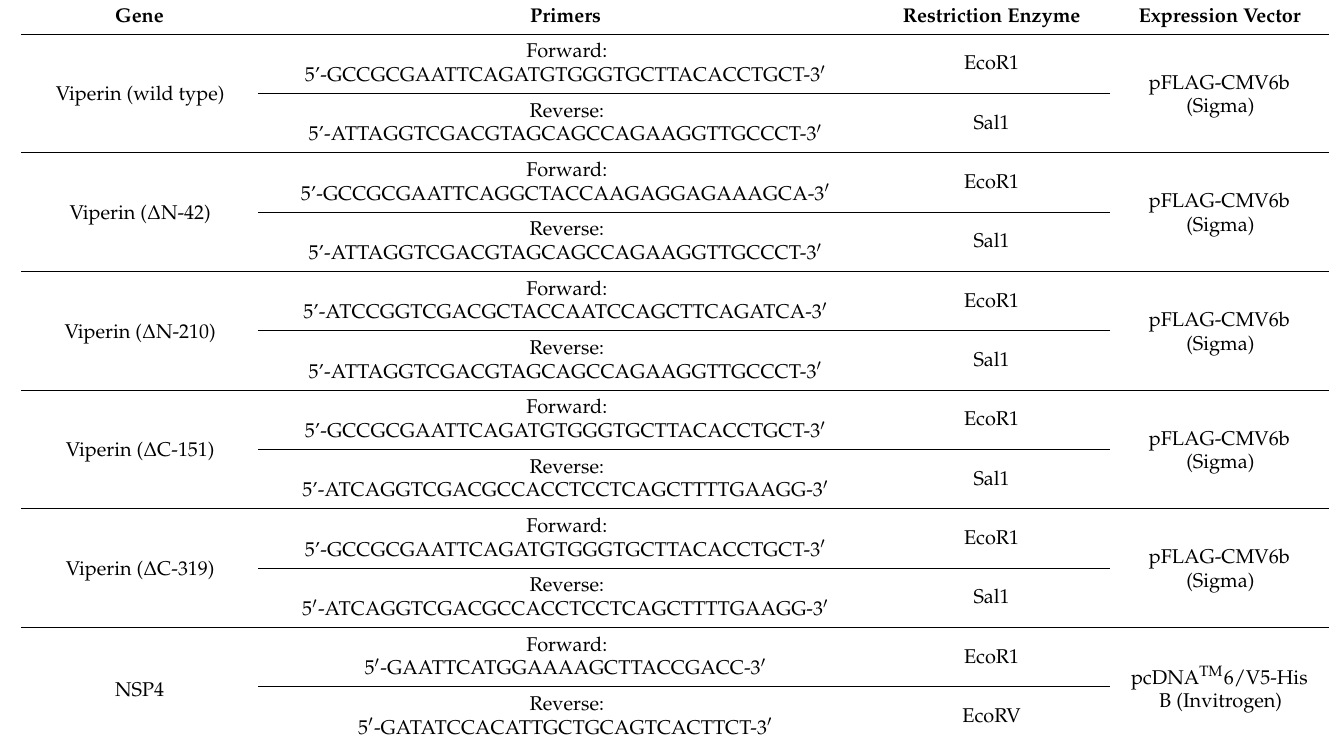
Table 1. List of primers used for the